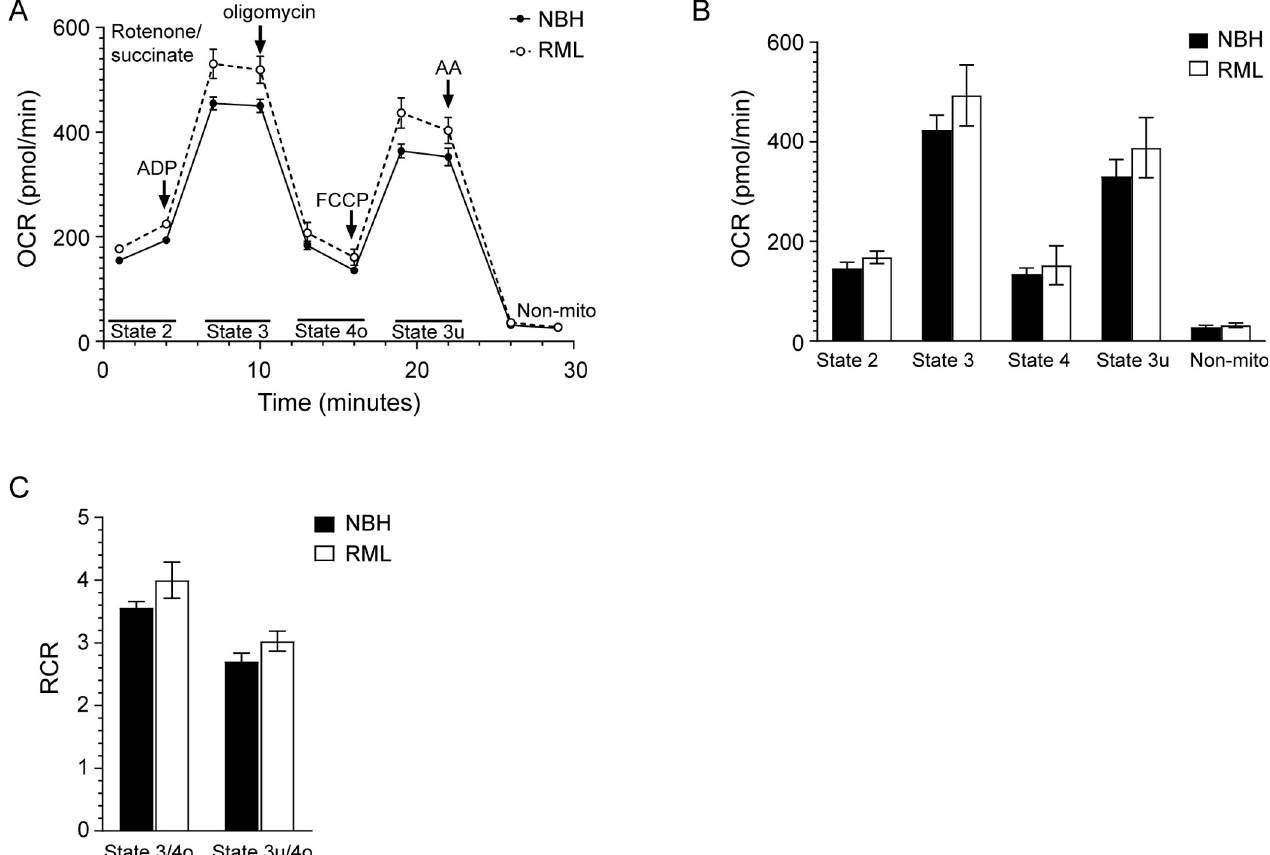
Fig 7. No significant difference in mitochondrial oxygen consumption in SARM1 KO mice infected with RML prions. (A) Mitochondrial coupling assay measuring mitochondrial respiration for clinically positive SARM1 KO mice infected with RML prions (open circle, dotted line) or inoculated with NBH (black circle, solid line). A total of n = 6 mice were assayed for each condition. The reagents added during the 30 min assay as well as the states quantified are indicated. AA = antimycin A; Non-mito = non mitochondrial respiration. (B) OCRs and (C) RCRs for the data in Panel A. Values were calculated as described in the materials and methods. Black bars = NBH inoculated, white bars = RML inoculated. For all panels, the mean ± SEM is shown.